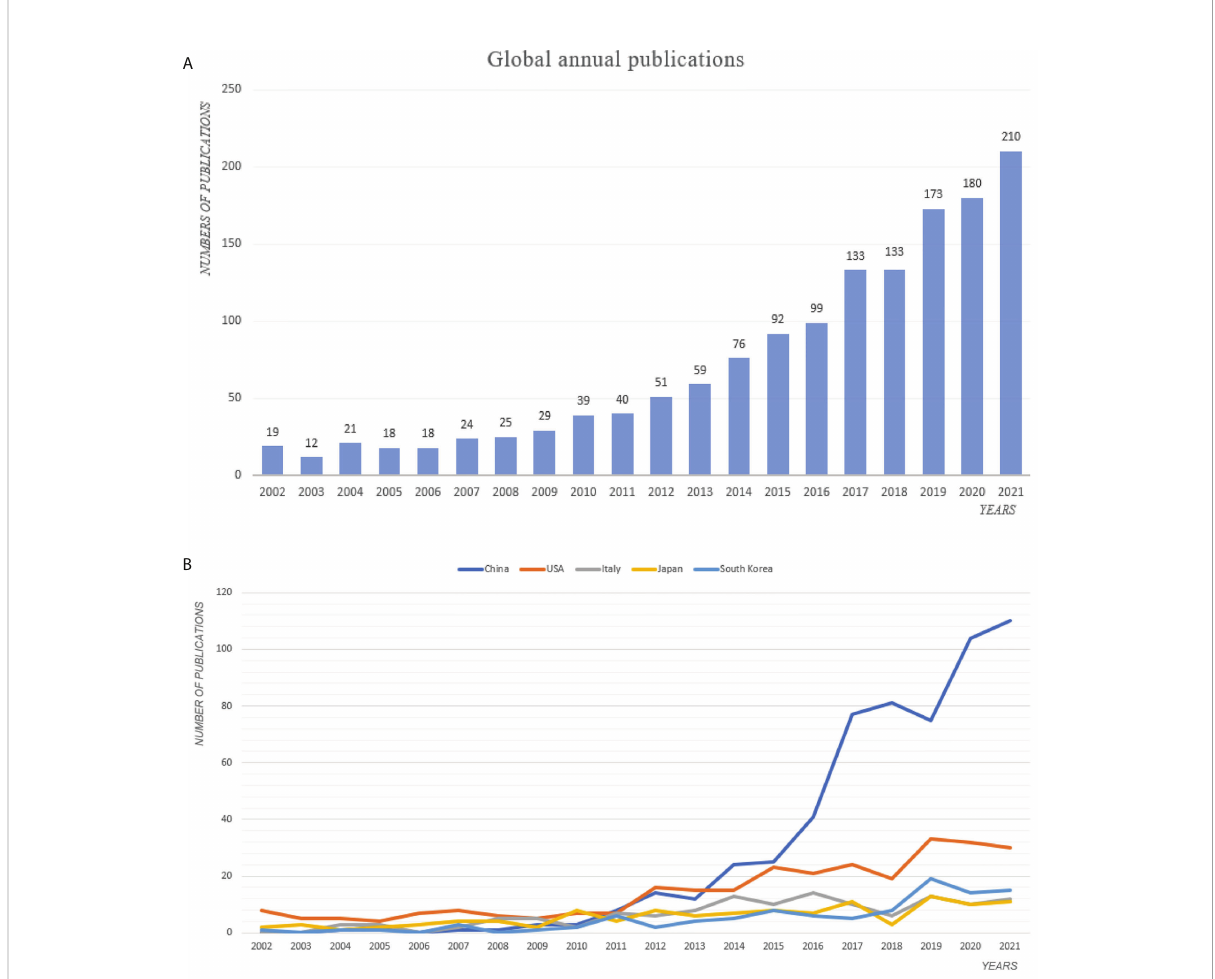
FIGURE 2 The number of annual publications on drug resistance and colorectal cancer from 2002 to 2021. (A) Global; (B) Top5 Countries or